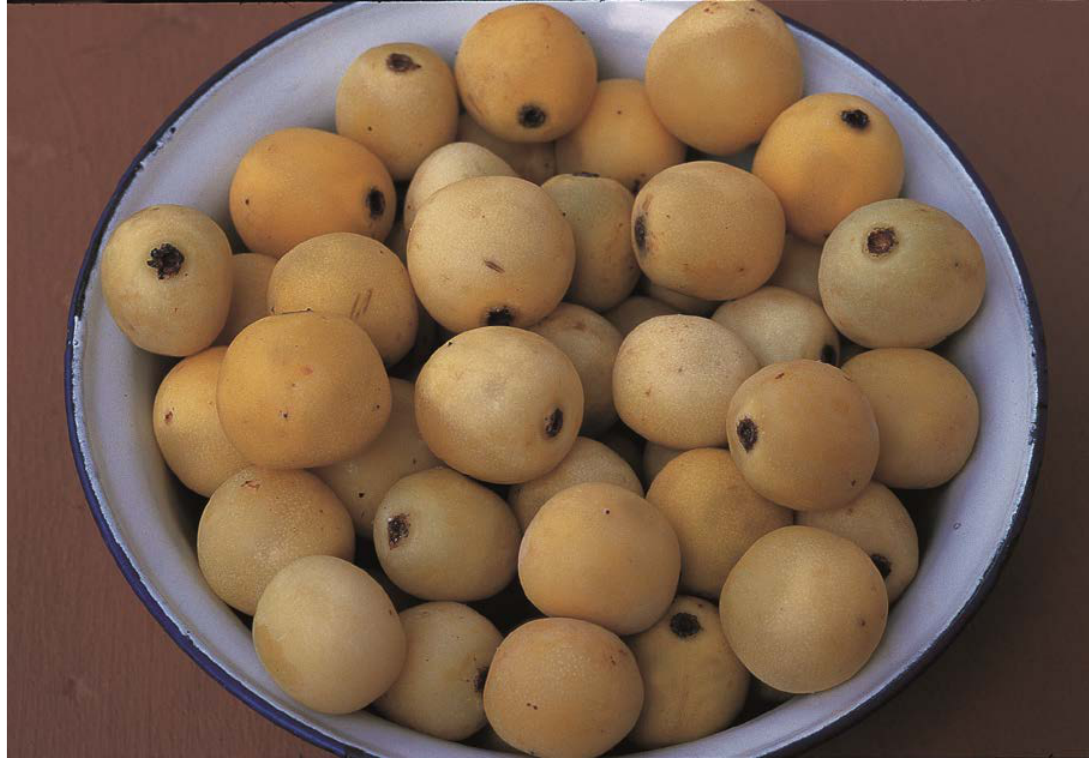
Figure 1. Sclerocarya birrea (A.Rich.) Hochst. (Anacardiaceae). Image provided by Ben-Erik van Wyk.